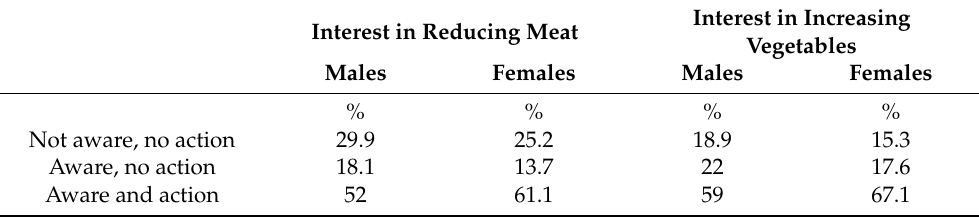
Table 5. “Interest in Reducing Meat” groups and “Interest in Increasing Vegetables” groups by gender *. Interest in Increasing Interest in Reducing Meat Vegetables Males Females